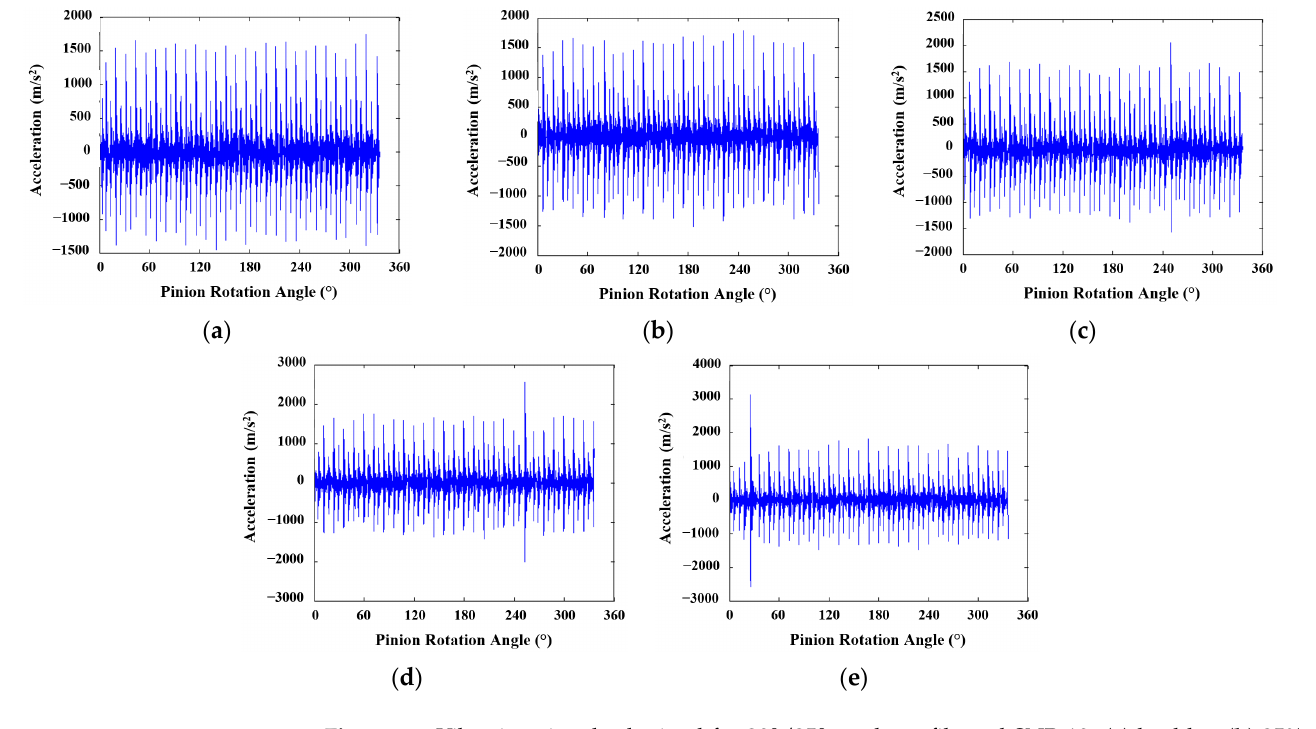
Figure 10. Vibration signals obtained for 20°/25° tooth pro fi le and SNR 10: ( a ) healthy; ( b ) 25%; ( c ) 50%; ( d ) 75%; ( e ) 100% crack levels.